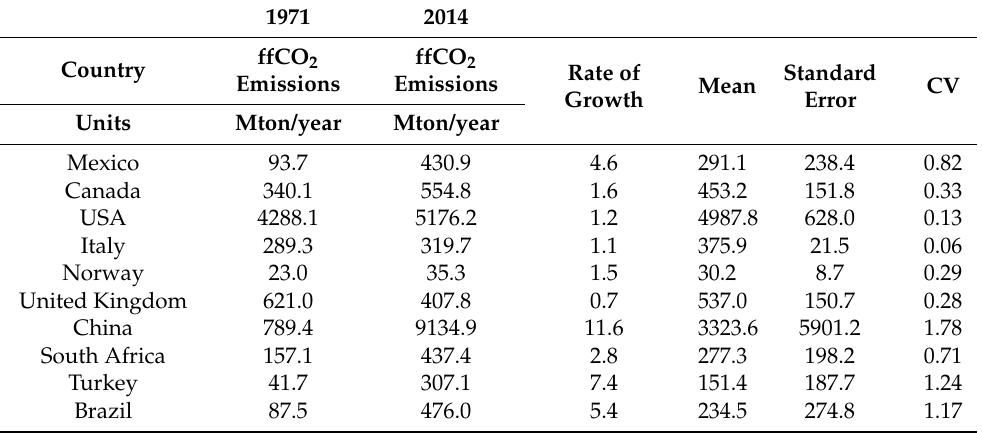
Table 1. Environmental variable, comparison of variations coefficients from the year 1971 to